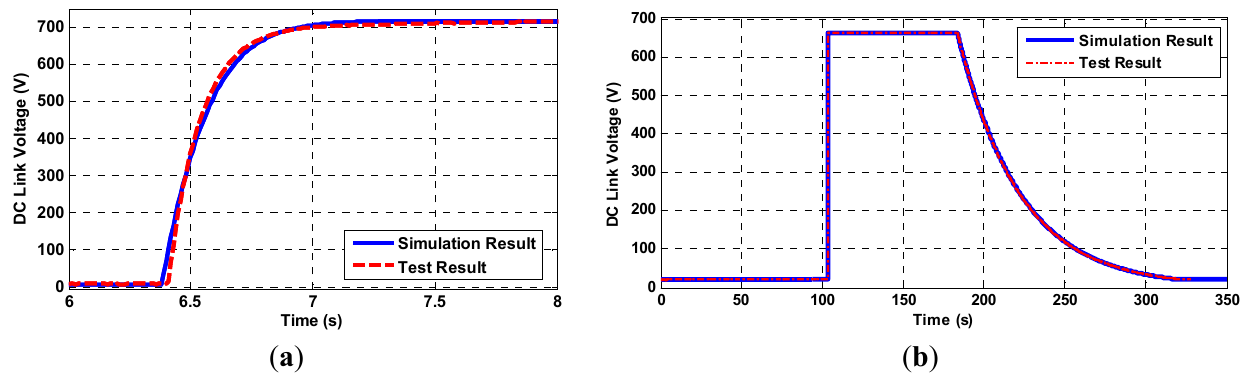
Figure 7. Relay assembly model identification: ( a ) Pre-charging, ( b )